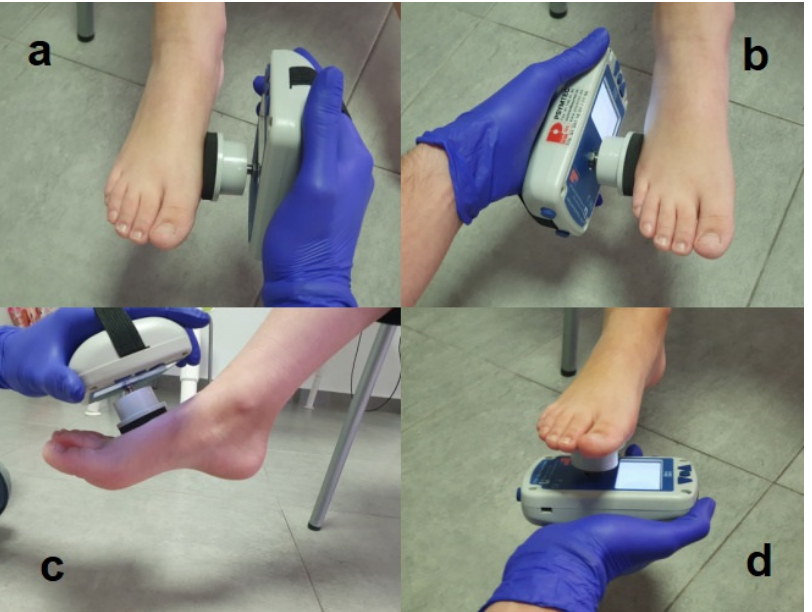
Figure 2. Assessment of ankle strength using the dynamometer: ( a ) inversion assessment, ( b ) eversion assessment, ( c ) dorsiflexion assessment, ( d ) plantar flexion assessment.